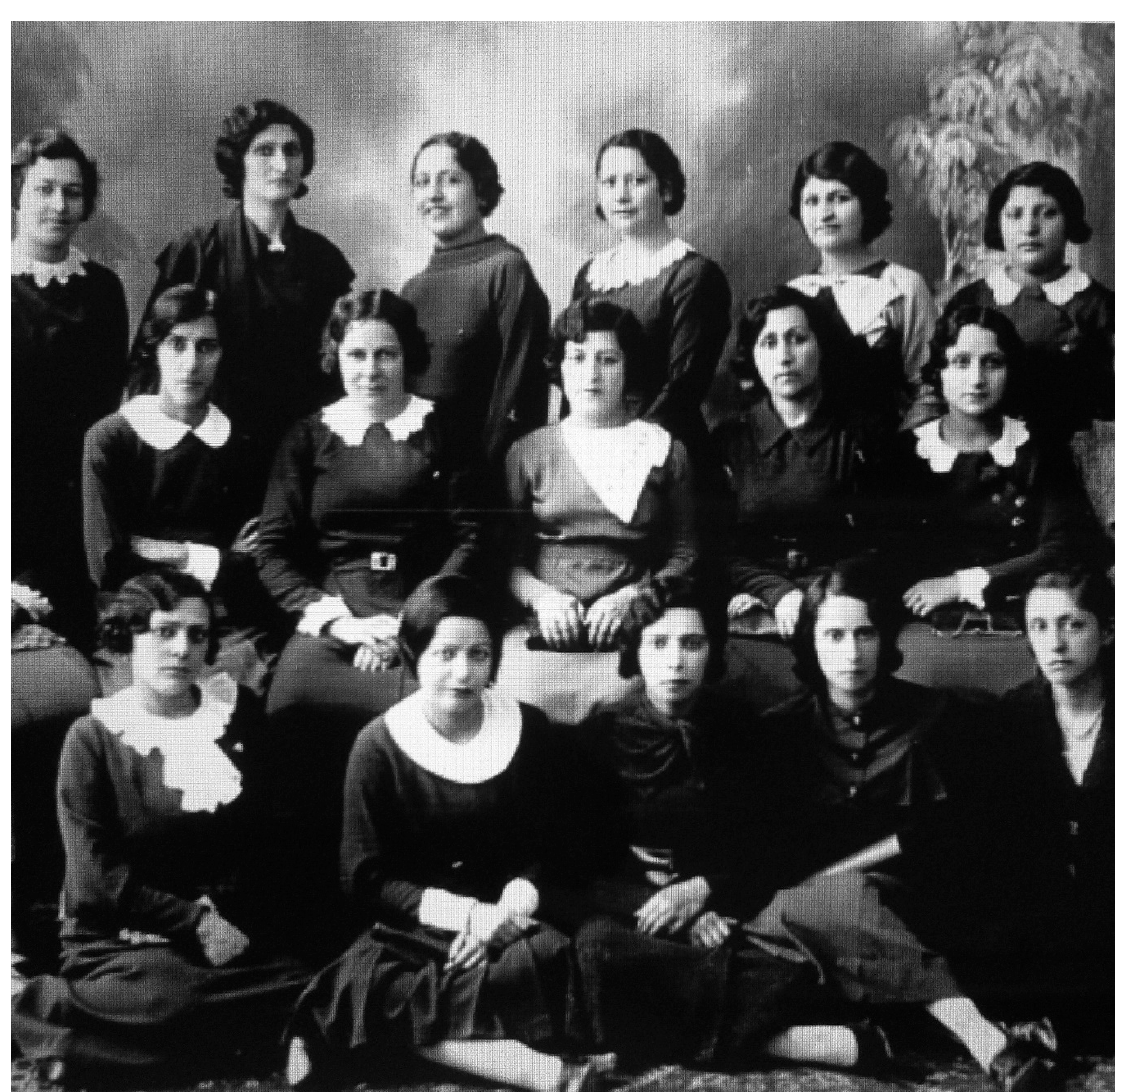
Figure 2. Association of the Progressive Iranian Women. 1936 ( Kanoun-e-Banovan ) Source: Internet Google